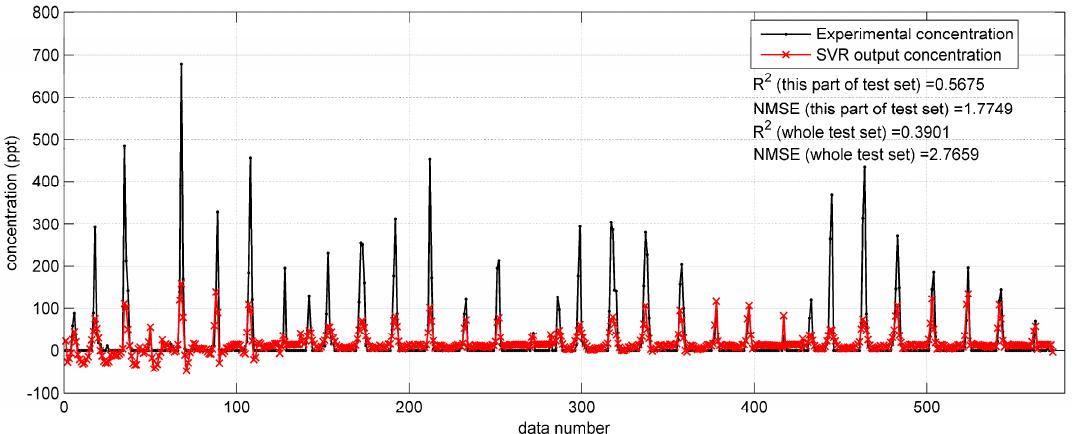
Figure 6. The prediction results of support vector regression (SVR) with original input parameters on the prairie Grass test set.